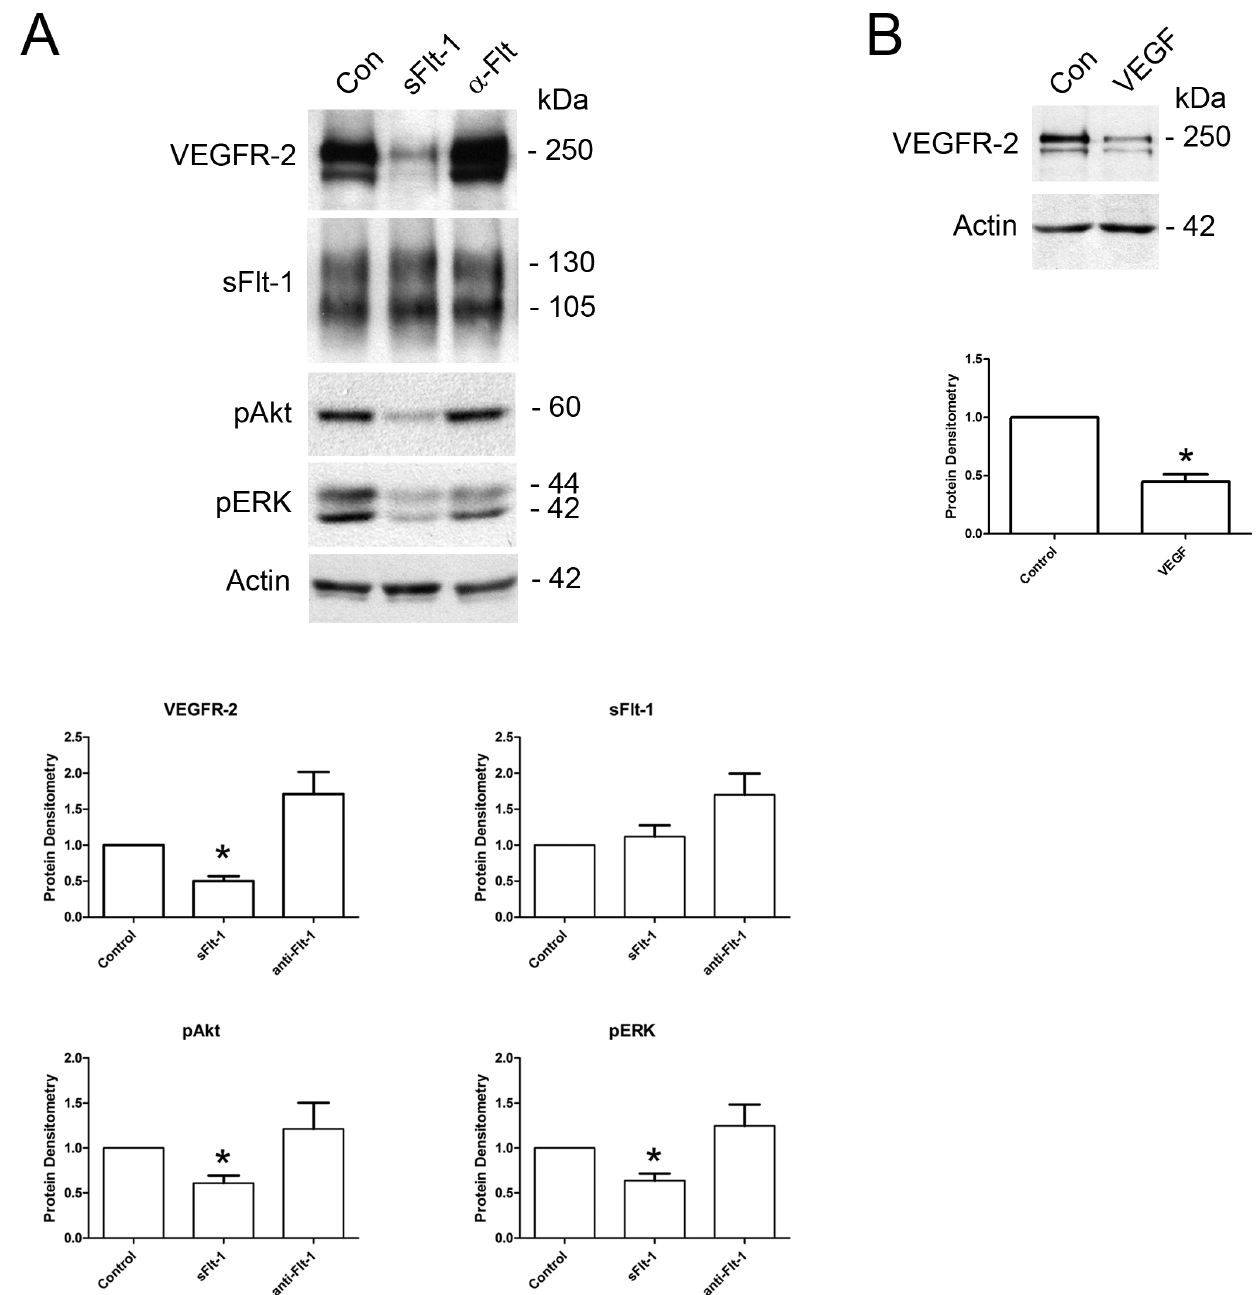
Figure 5. sFlt-1 directly attenuates VEGFR-2 expression and downstream signalling in placental villous explants. A: Representative VEGFR-2, sFlt-1, pAkt and pERK immunoblots of first trimester placental villous explants treated with sFlt-1 or a blocking antibody to sFlt-1. Densitometry analyses comparing normalized VEGFR-2, sFlt-1, pAkt and pERK in treated samples (Con, control; sFlt-1, sFlt-1 protein; a -Flt, Flt-1 neutralizing antibody; n=3, * P , 0.05). All values are represented as the means 6 SEM. B: Representative VEGFR-2 immunoblot of first trimester placental villous explants treated with VEGF. Densitometry analyses comparing normalized VEGFR-2 between control and VEGF-treated samples (Con, control; VEGF, VEGF-treated; n=3, * P , 0.05). All values are represented as the means 6 SEM.